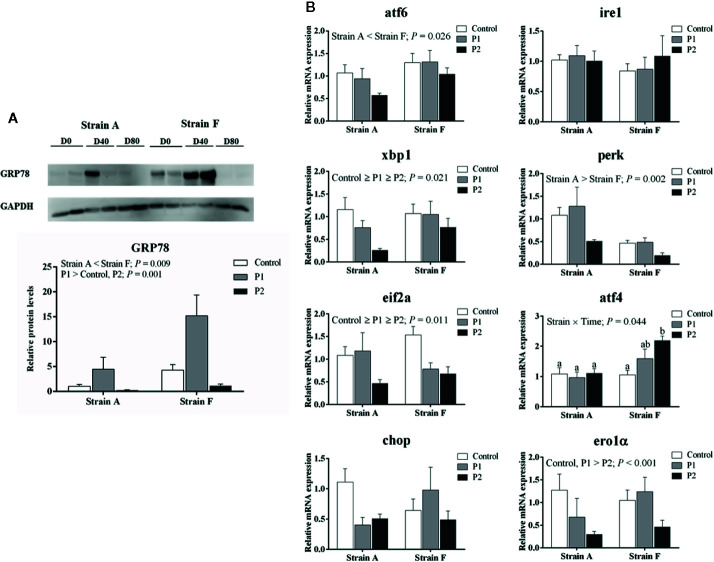
Protein levels of GRP78 (A) and expression levels of genes related to ER stress (B) in the livers of two strains of gibel carp starved for 0 days (C, white bars), 38 days (P1, gray bars), and 77 days (P2, black bars) during winter. Data were presented as mean ± SE (n = 6), and the differences were evaluated by two-way ANOVA (P < 0.05). When interactions were identified, different lowercase letters represented the significant differences among all groups (P < 0.05). GRP78, 78-kDa glucose-regulated protein; atf6, activating transcription factor 6; ire1, inositol-requiring protein-1α; xbp1, X-box-binding protein 1; perk, eukaryotic translation initiation factor 2-alpha kinase 3; eif2a, eukaryotic translation initiation factor 2A; atf4, activating transcription factor 4; chop, DNA damage-inducible transcript 3 protein; ero1α, endoplasmic reticulum oxidoreductase 1 alpha.